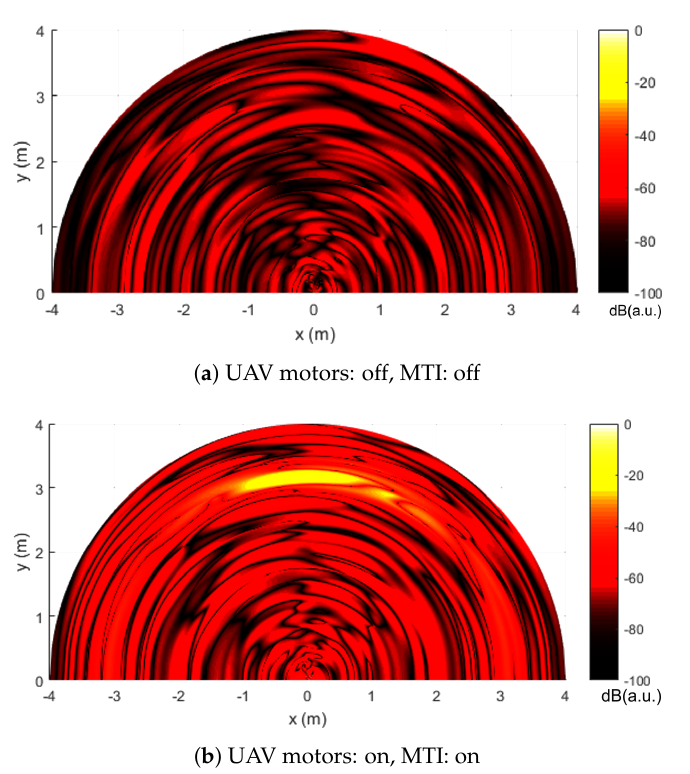
Figure 4. Radar image of the quad-copter UAV obtained with a moving target indicator (MTI) evidencing the micro-Doppler